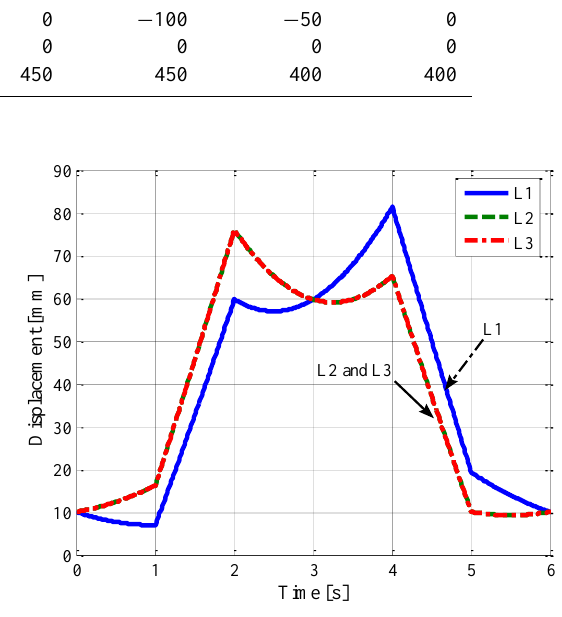
Figure 7. Input displacements of the three linear